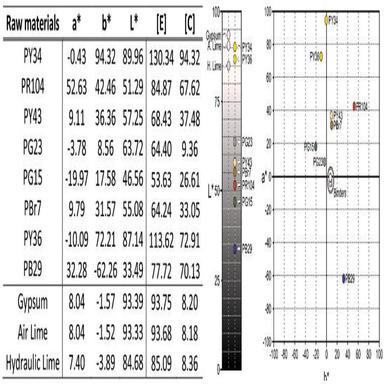
Left. CIELAB 1976 color coordinates of pigments and binders tested under illuminant D65. Where a\, means the amount of red (+) or green (-). b\, means the amount of yellow (+) or blue (-). L\, means the amount of light in one degree from black (0) to white (100), means total color of the sample and means the chroma of the sample. Right. Representation in the CIELAB-1976 system of pure pigments and binders used in the present study. (For interpretation of the references to color in this figure